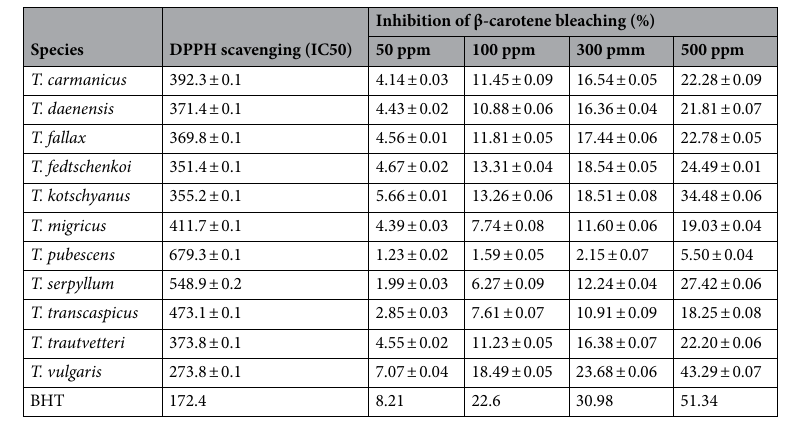
Table 3. Antioxidant activity of 11 Thymus species based on DPPH and β-carotene-linoleic acid model systems. Means with different letter are statistically significant at 5% level